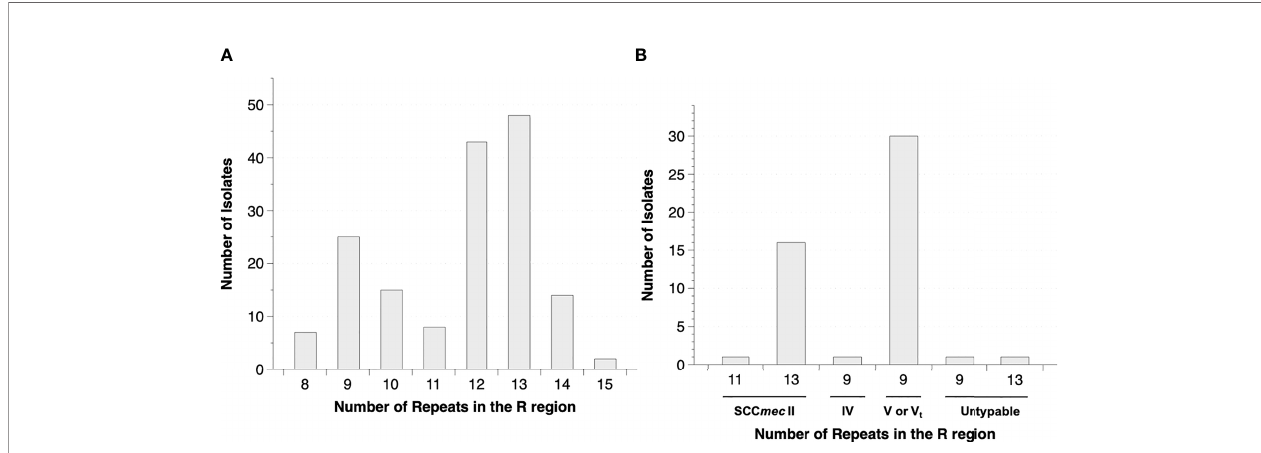
FIGURE 2 | Different repeat copies distribution in (A) oxacillin-sensitive Staphylococcus lugdunensis (OSSL); (B) oxacillin-resistant S. lugdunensis (ORSL) with different SCC mec .